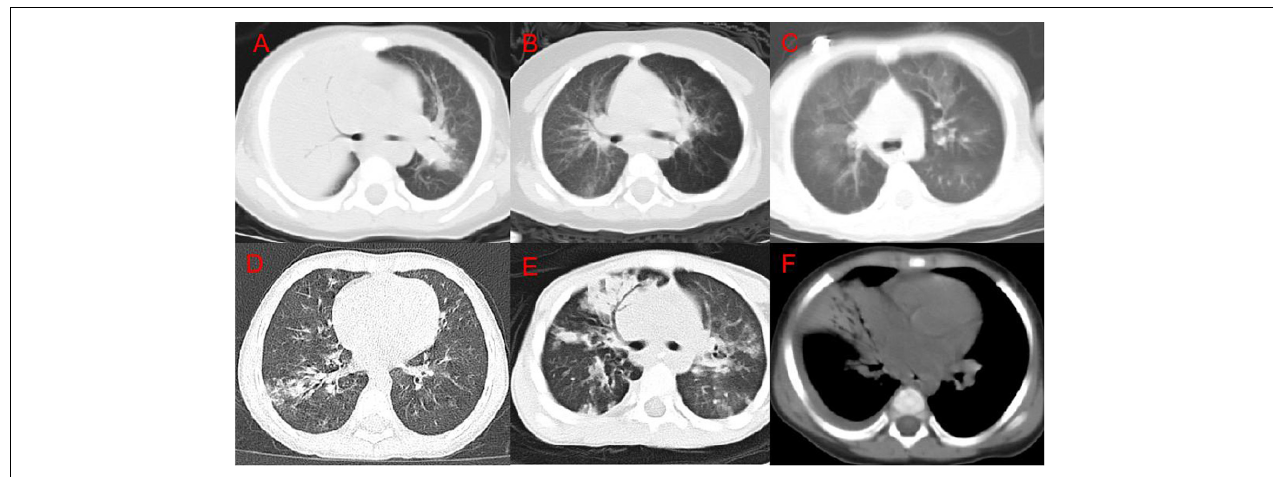
FIGURE 2 | Chest CT imaging findings of adenovirus pneumonia. (A) Right upper lung consolidation with bronchial inflation sign; (B) left emphysema; (C) double lung mosaic sign; (D) right lower lung bronchial wall thickening and surrounding lobule inflammation; (E) right Middle lung bronchiectasis; (F) a small amount of pleural effusion on the right.